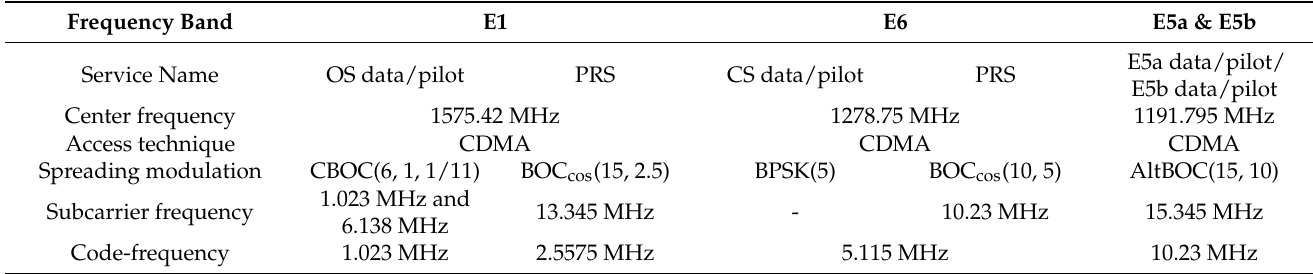
Table 1. The Galileo signal technical characteristics in different